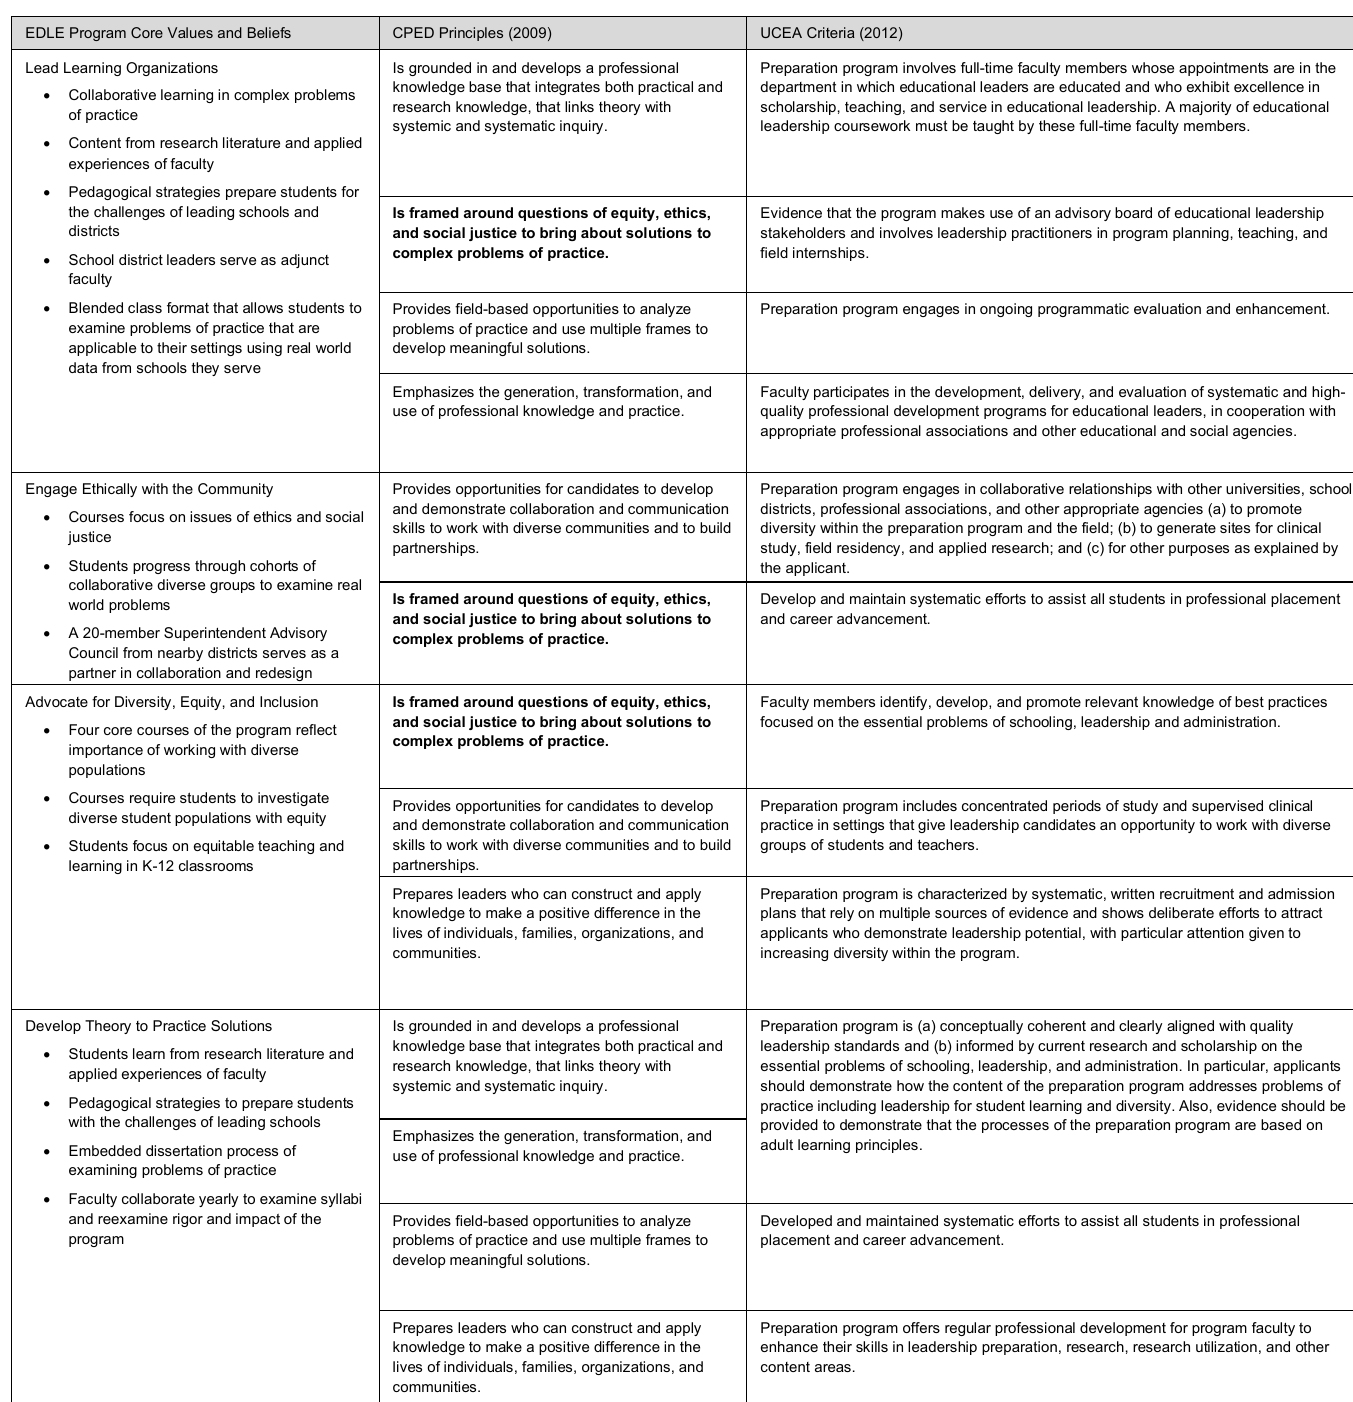
Table 1. Alignment of the Program’s Core Values and Beliefs with CPED Principles and UCEA